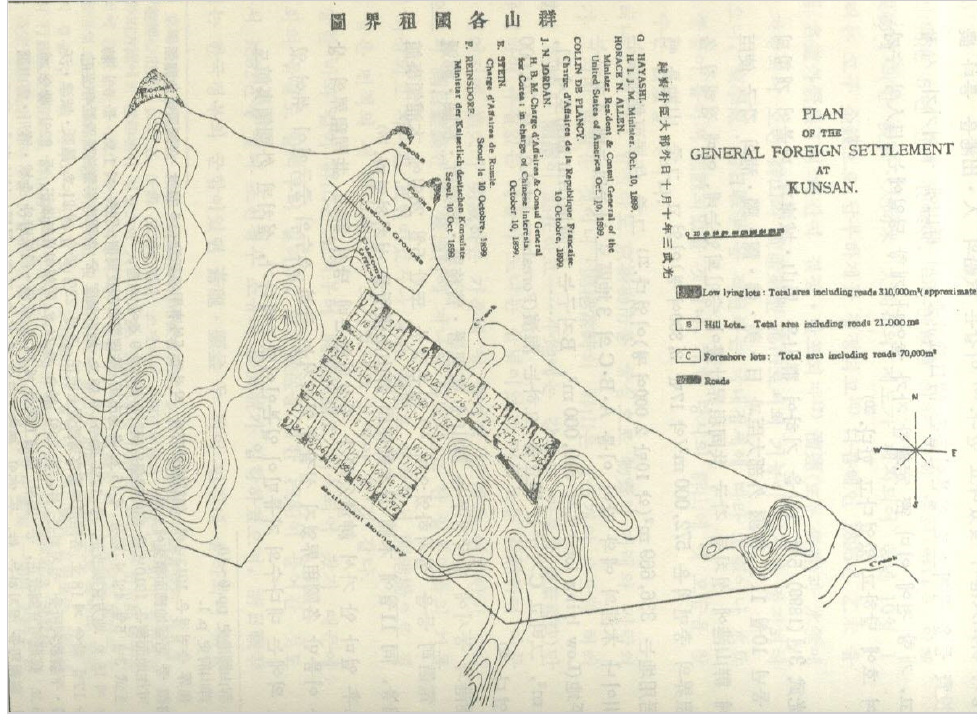
Figure 1. Foreign settlement map in Gunsan, 1899 [22] .